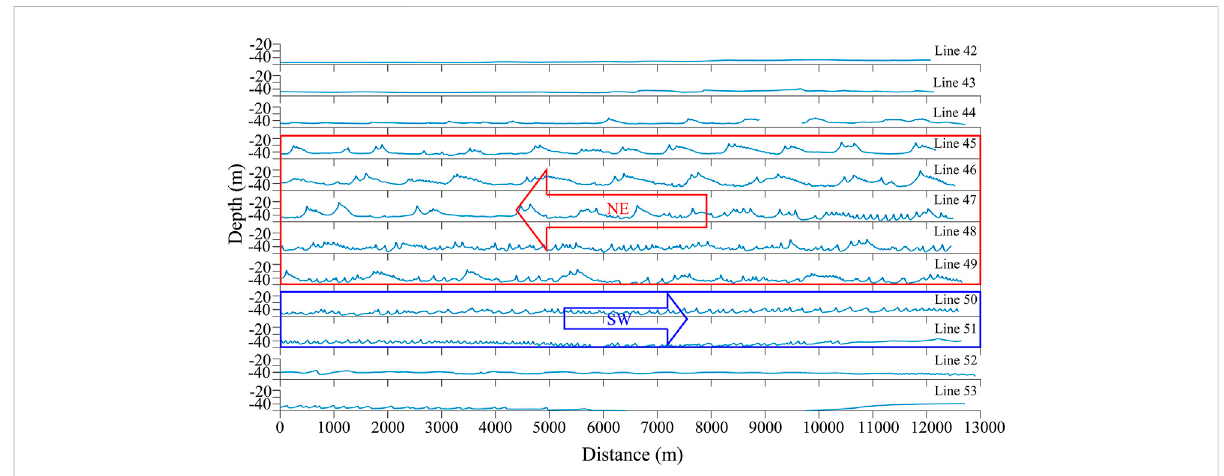
FIGURE 6 Overall sandwave migration patterns from pro fi les of survey lines. Lines in the red box are sandwaves primarily migrating upcoast (toward northeast); lines in the bule box are midsize sandwave migrating downcoast (toward